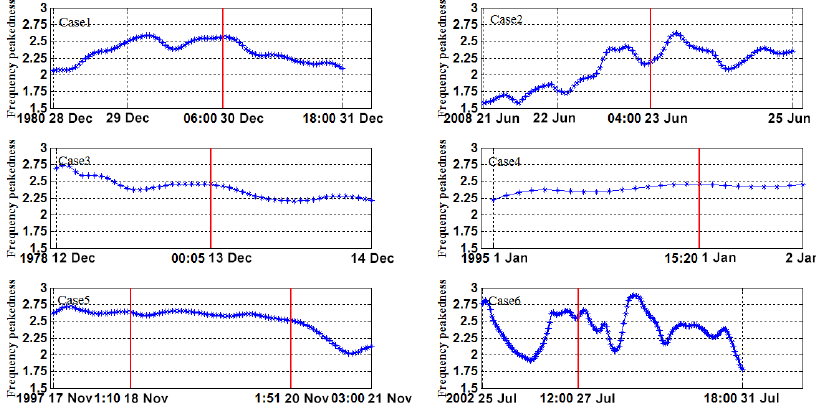
Figure 3. Time series of simulated frequency peakedness (cases 1–6), red lines refer to the freak waves occurrence time.